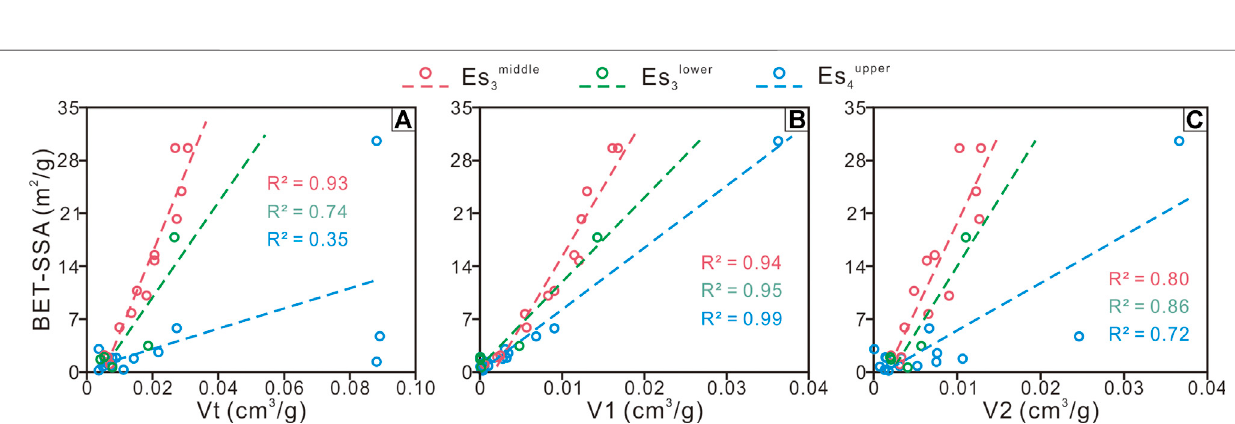
Frontiers in Earth Science |